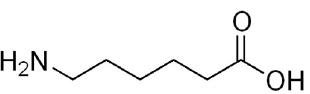
Figure 1. Structure of 6-aminohexanoic acid.